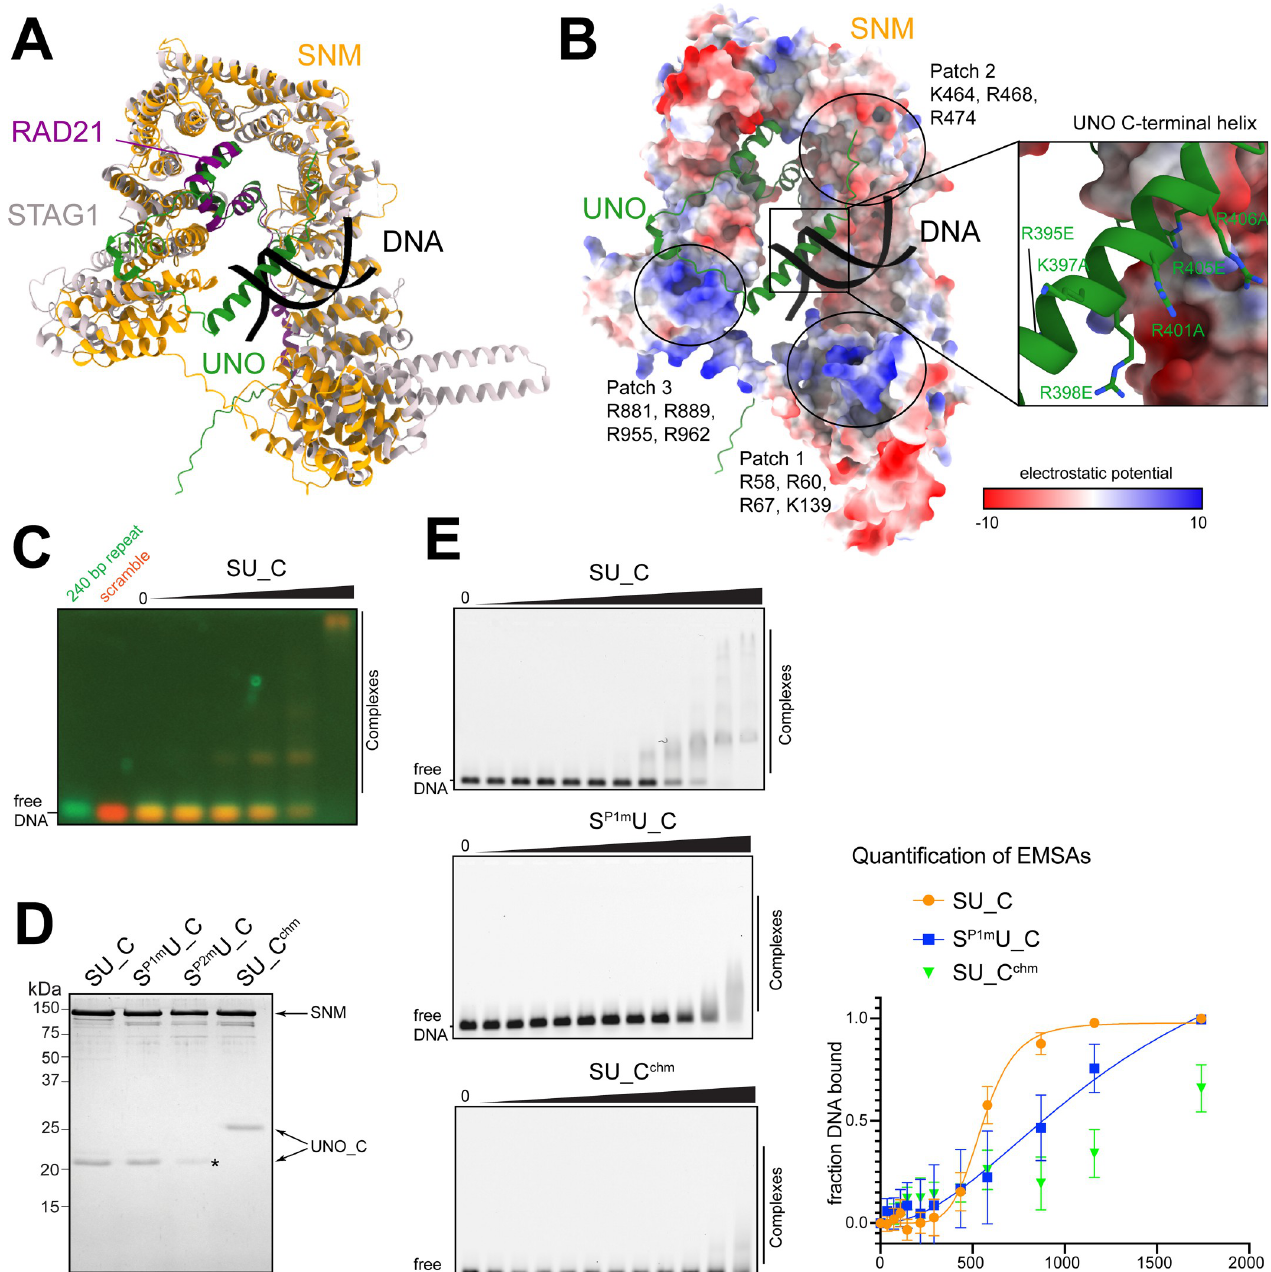
Fig 4. The SU_C complex binds to DNA. ( A ) Structural comparison of SU_C with STAG1/RAD21 from the human cohesin complex. The structure of STAG1, RAD21 and dsDNA (PDB 6wg3, [36]) was superposed on the SU_C model using Chimera MatchMaker, giving a local C-alpha RMSD of 1.31 Å over 272 residues, and a global C-alpha RMSD of 8.1 Å over all 863 pairs. ( B ) Surface representation of SNM colored by electrostatic potential to highlight three potential DNA-binding patches that are common with STAG1. UNO_C is shown as a cartoon representation. The inset (right) shows the positively charged residues of the C-terminal helix of UNO that were mutated (see below). The position of dsDNA is taken from the STAG1/RAD21 model shown in (A). ( C ) DNA-binding of SU_C. For analysis by EMSA, SU_C was incubated with a mix of two distinct DNA fragments, fluorescently labeled with a green and a red dye, respectively. The sequence of the first DNA fragment corresponded to that of the 240 bp repeat previously implicated in sex chromosome conjunction before male M I [26]. A scrambled version of the same sequence was present in the second fragment. Band shifts revealed DNA-binding by SU_C without preference for the 240 bp repeat. ( D ) SU_C and mutant versions of this complex were purified and analyzed by SDS-PAGE and Coomassie staining. S P1m : SNM with mutant basic patch 1, S P2m : SNM with mutant basic patch 2, C chm : UNO_C with mutations in C-terminal helix. S P2m resulted in a reduced presence of UNO_C (asterisk) and C chm in an altered electrophoretic mobility of UNO-C. ( E ) Representative EMSAs for comparison of DNA-binding activity of SU_C